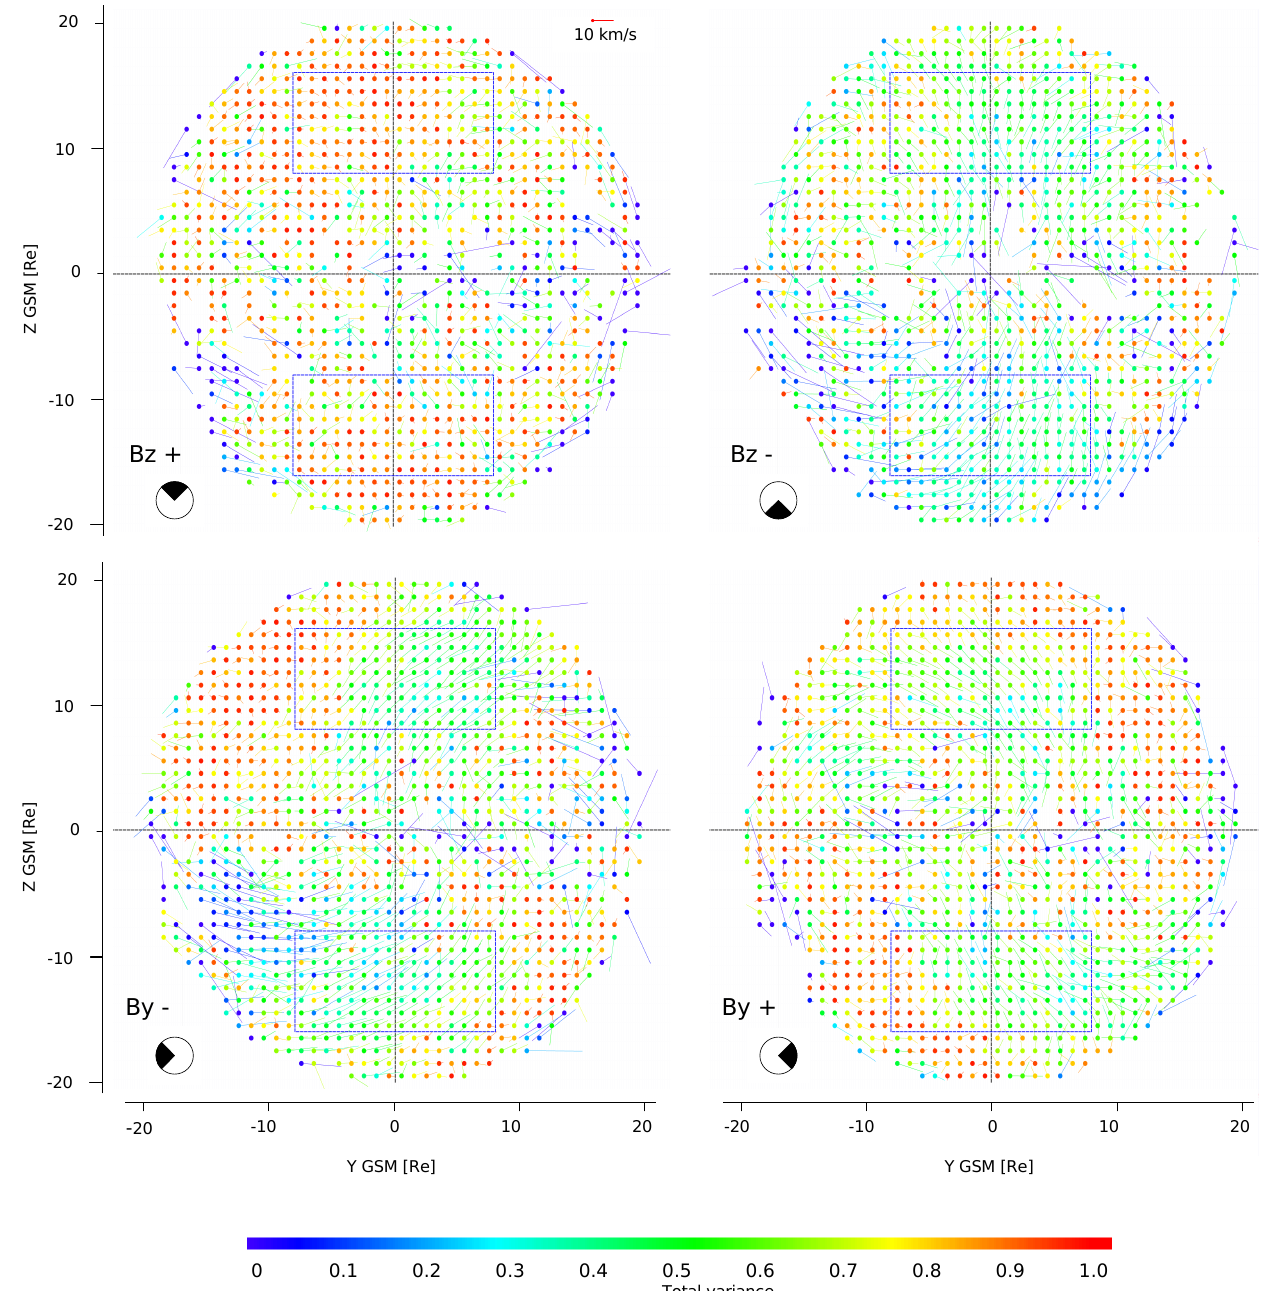
Fig. 4. Convection patterns in the lobe at X = − 10 R E as function of the IMF direction. Sector symbols in the lower left corner of each panel indicate the IMF clock angle sector, and the colors and color bar indicate the normalized total variance for each bin. The view is from the Earth, looking tailward. Blue boxes in the northern and southern lobe are two reference regions used for calculation of characteristic averages and correlations between convection and various driver parameters. Average convection velocities, calculated cross-tail potential drop and the number of records within these regions are given in Table 2.